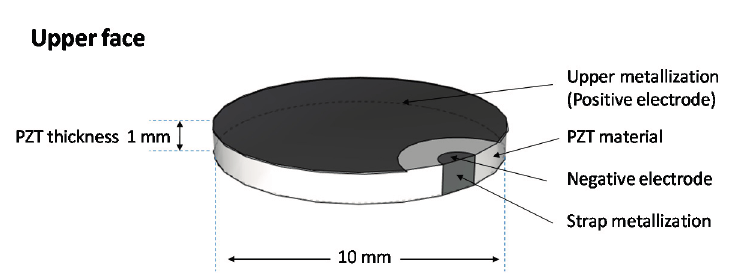
Figure 14. ( a ) Designed sensor; ( b ) Generated stimulus in time domain: Pure sinus modulated using a Hanning window; ( c ) Generated stimulus in frequency